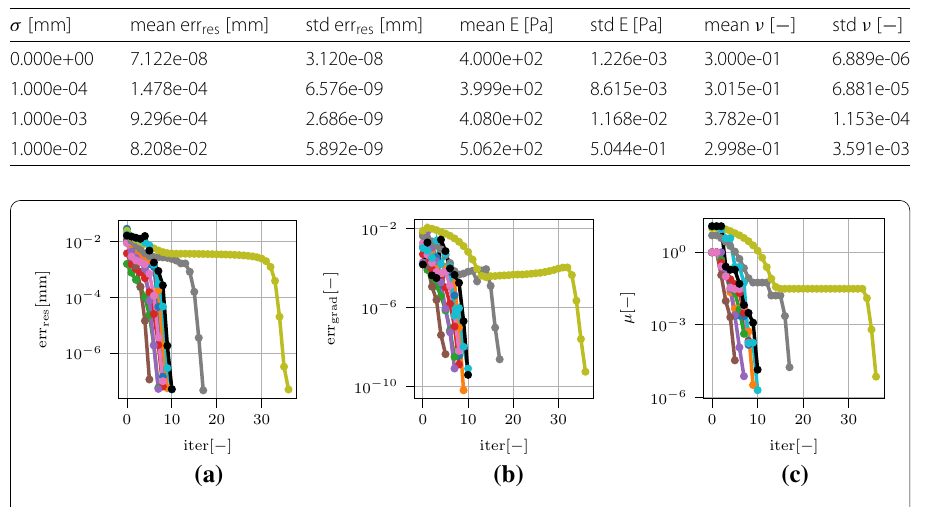
Fig. 5 Development of a residual error err res , b gradient based error err grad and c regularization parameter μ for inverse analysis runs with different initial guesses over iterations